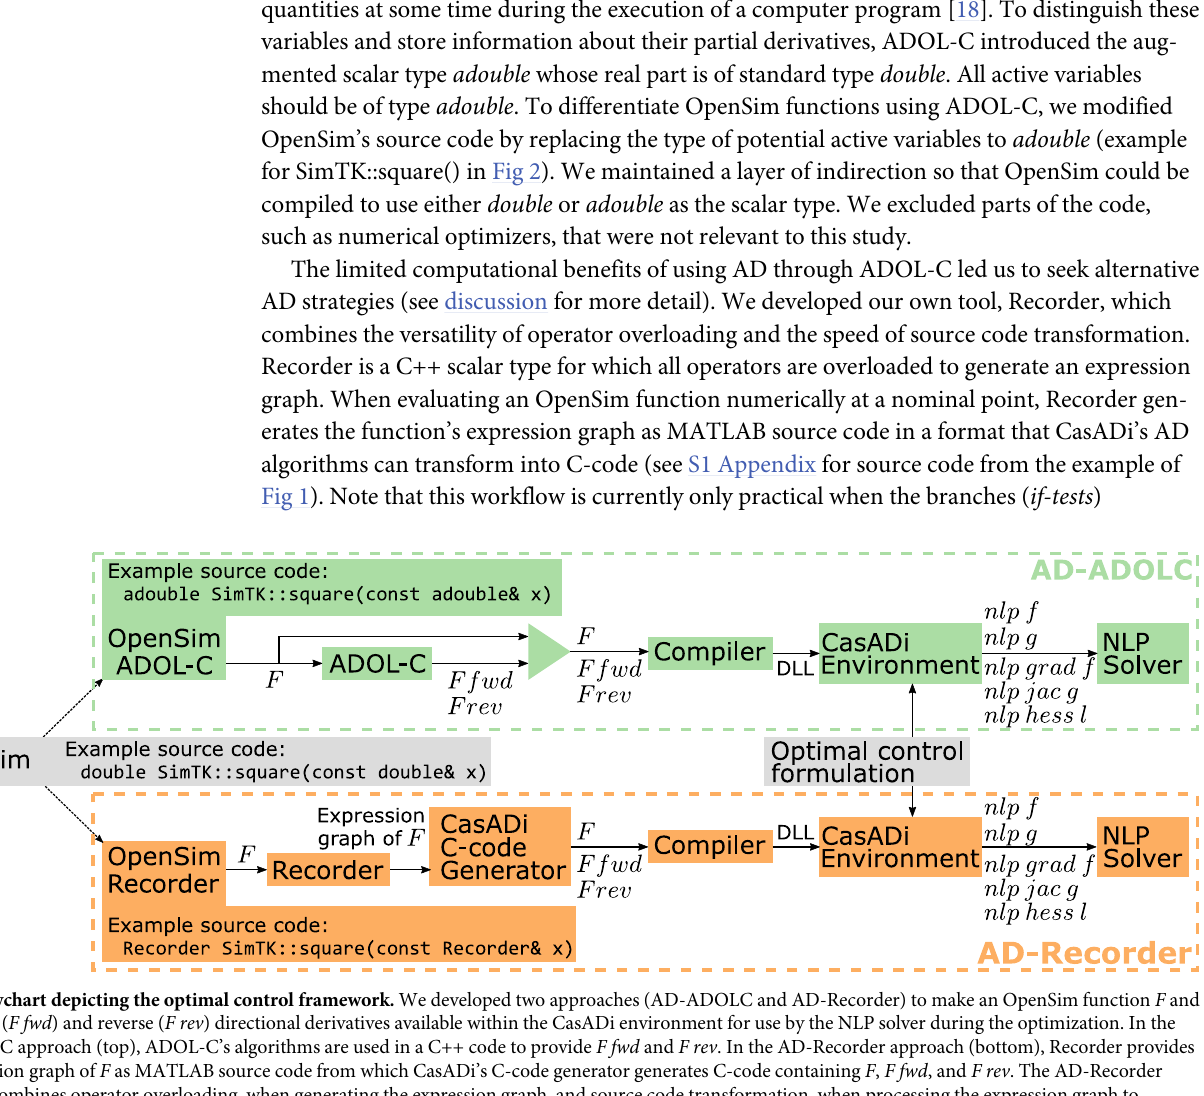
Algorithmic differentiation speeds up trajectory optimizationof